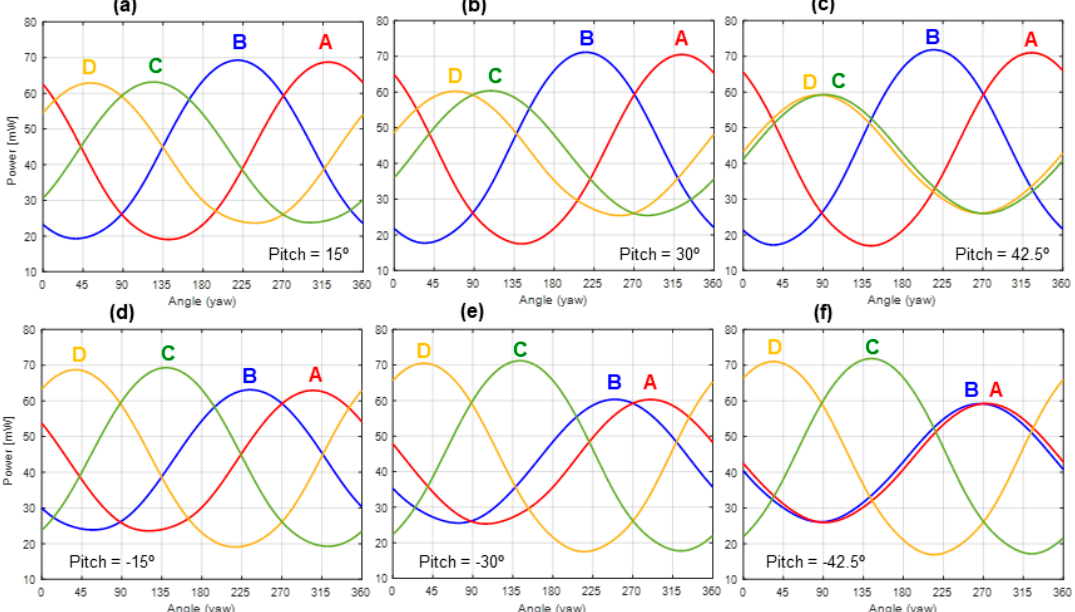
Figure 14. Simulation results showing the power delivered to the four sector resistors of the sensor for complete yaw rotations and six different pitch angles. Pich angles are: ( a ) 15 °, ( b ) 30°, ( c ) 42.5° and ( d ) − 15°, ( e ) − 30°, ( f ) − 42.5°. The sectors (A, B, C and D) follow the same disposition as the one